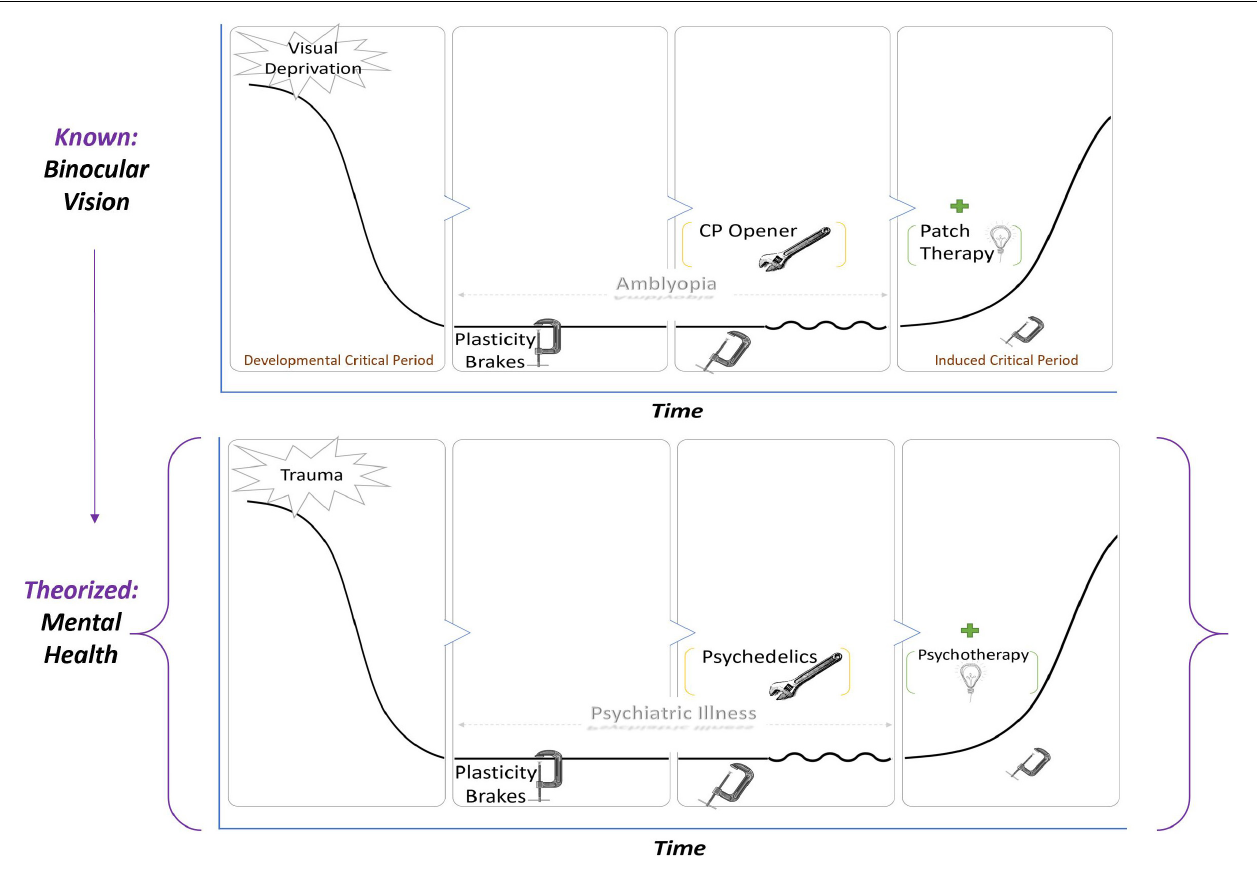
FIGURE 1 | A known paradigm in visual CPP is applied to a hypothetical model of PAP. In both top and bottom leftmost panels, an adverse environmental input such as trauma, stress, or deprivation enduringly alters functioning, resulting in amblyopia (top) or psychiatric illness (bottom). Because of brakes on plasticity, there is a valley that restricts or prevents major recovery. In the third panel, the brakes are removed by critical period plasticity openers such as SSRIs and valproic acid in the case of vision or possibly psychedelics in the case of psychiatric illness. Removing the brakes alone does not restore functioning but rather makes the system sensitive to environmental input. A therapeutic intervention—patch therapy for vision and psychotherapy for mental health—during the period of induced plasticity is what returns the system to